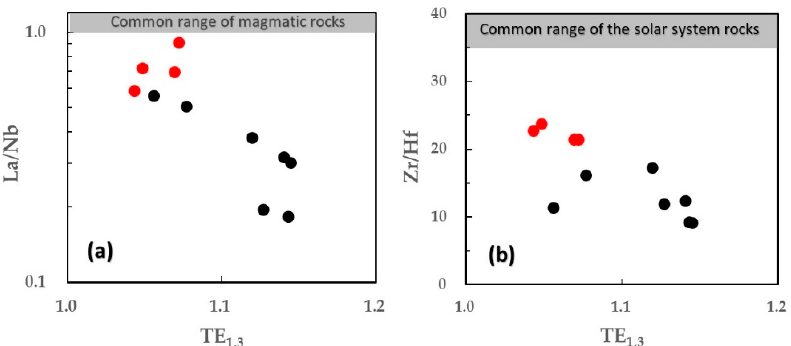
Figure 9. ( a ) La/Nb and ( b ) Zr/Hf vs. tetrad effects. Gray bands refer only to elemental ratios and not to TE 1,3 values [4]; ● A group; ● B group.